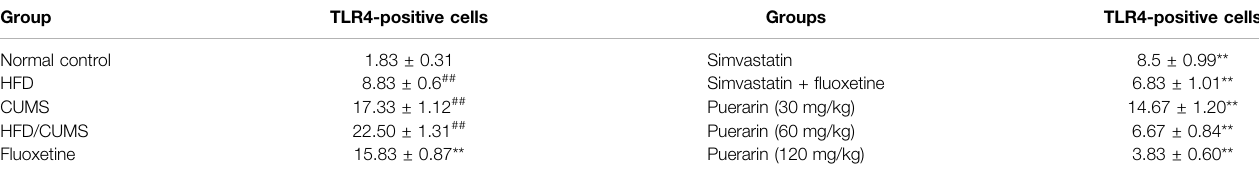
TABLE 2 | Semi-quanti fi cation of TLR4-positive cells.